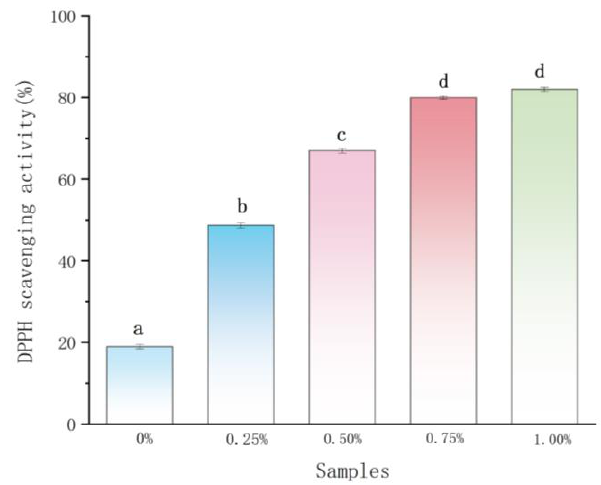
Figure 4. DPPH radical scavenging activity of chitosan films without and with different contents of magnolol. Notes: 0%, magnolol–chitosan film without magnolol. 0.25%, magnolol–chitosan film with 0.25% of magnolol. 0.50%, magnolol–chitosan film with 0.50% of magnolol. 0.75%, magnolol–chitosan film with 0.75% of magnolol. 1.00%, magnolol–chitosan film with 1.00% of magnolol.